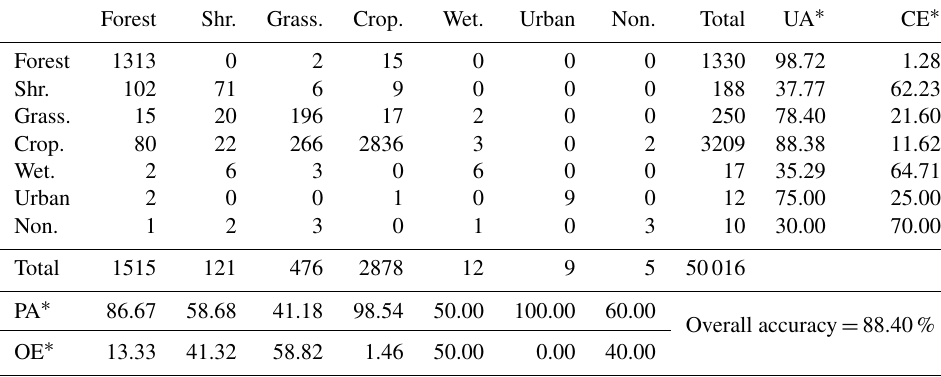
Overall accuracy = 88.40%